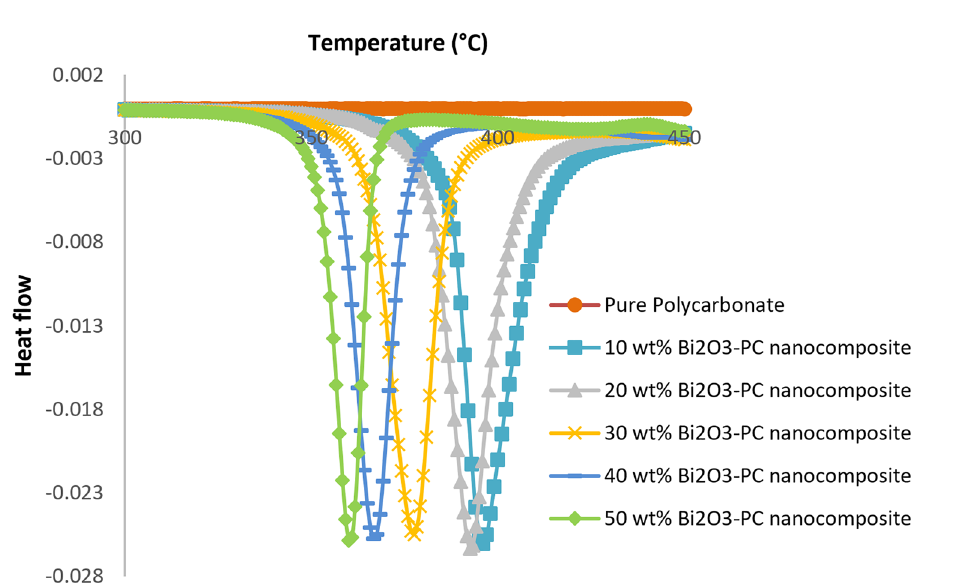
Figure 6. DTA thermograms of nanocomposites containing different levels of Bi 2 O 3 .